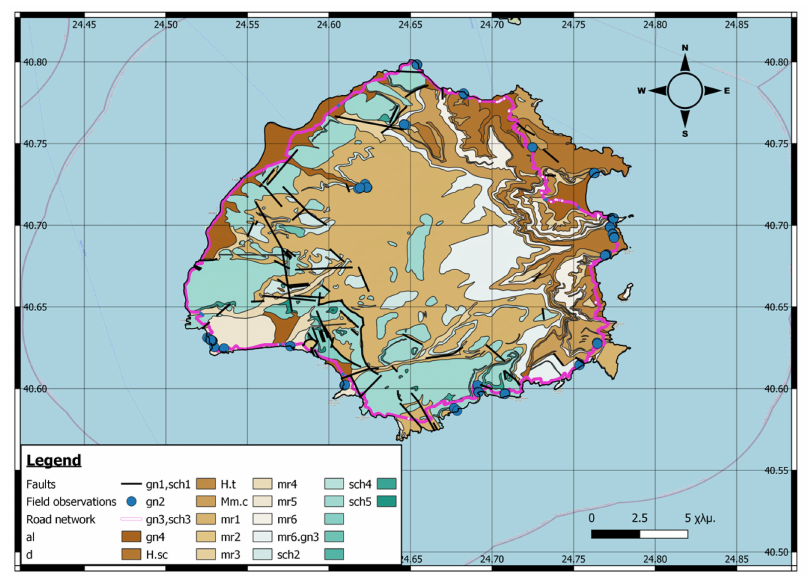
Figure 2. Geological map provided by the HSGME and field observations along the main road network on the island of Thasos (background layer is attributed to